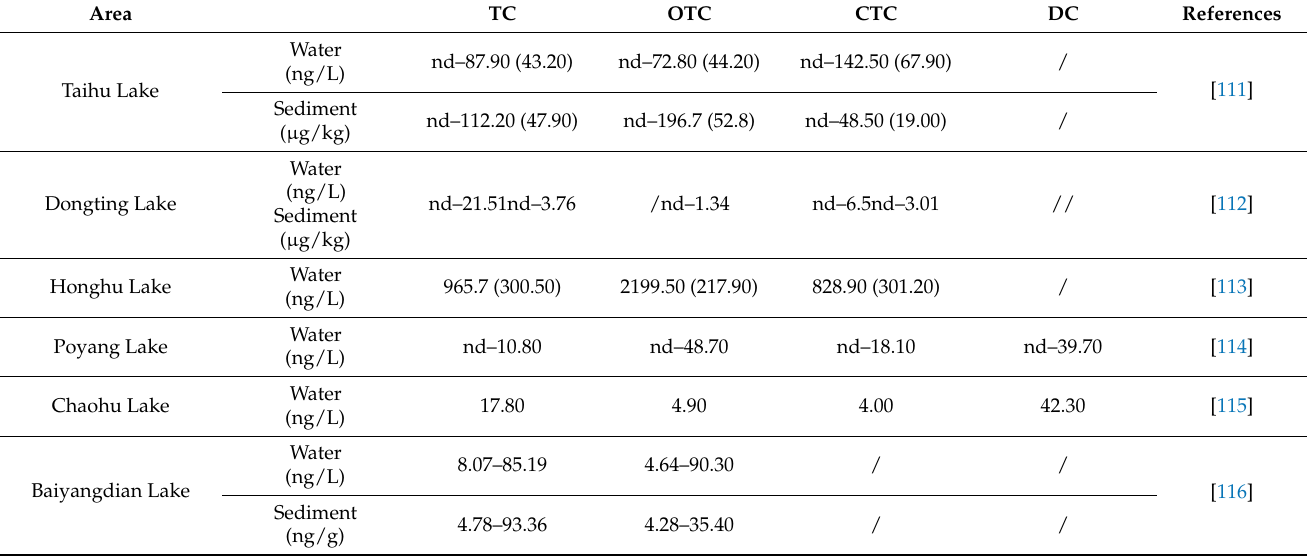
Table 4. Accumulation of TCs in water and